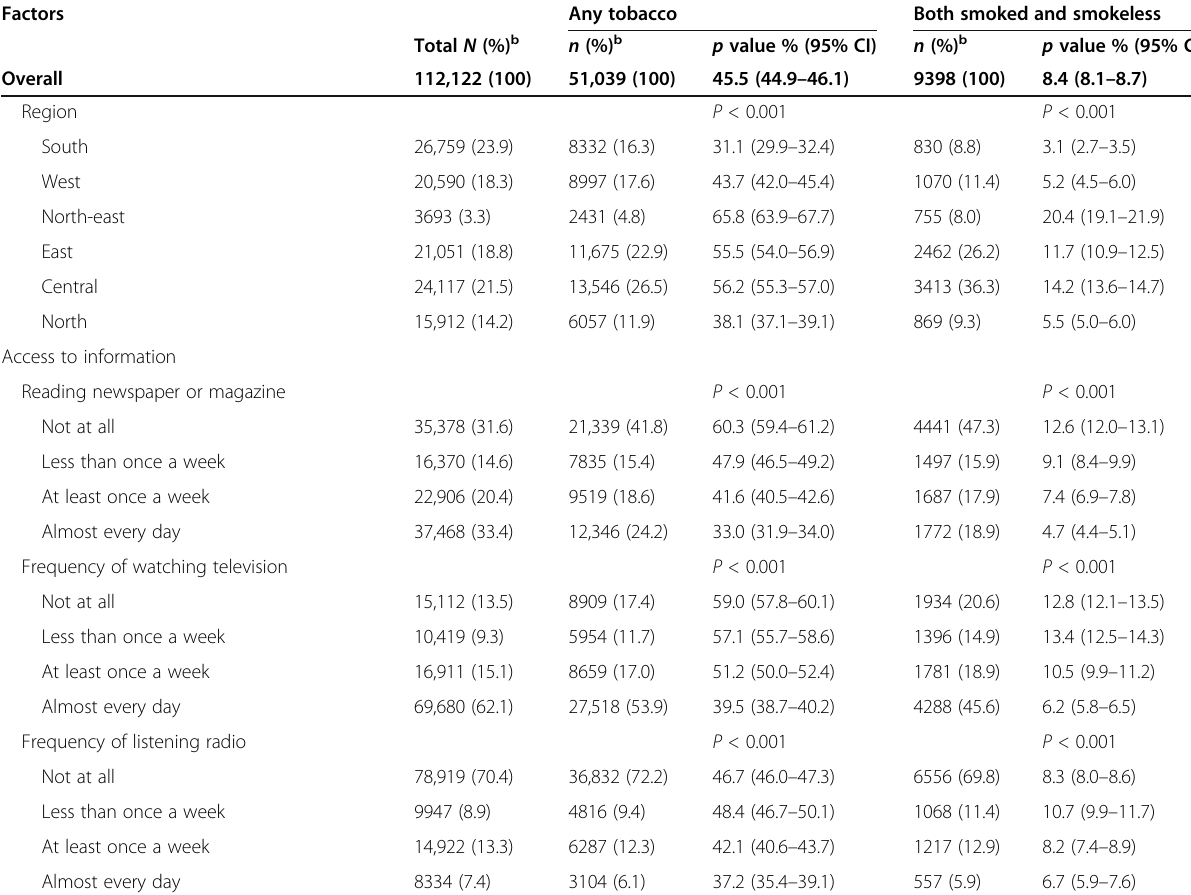
Table 2 Characteristics of the study population and prevalence of any tobacco and both smoked and smokeless tobacco use among Indian men by socio-demographic characteristics, India 2015 – 2016 a